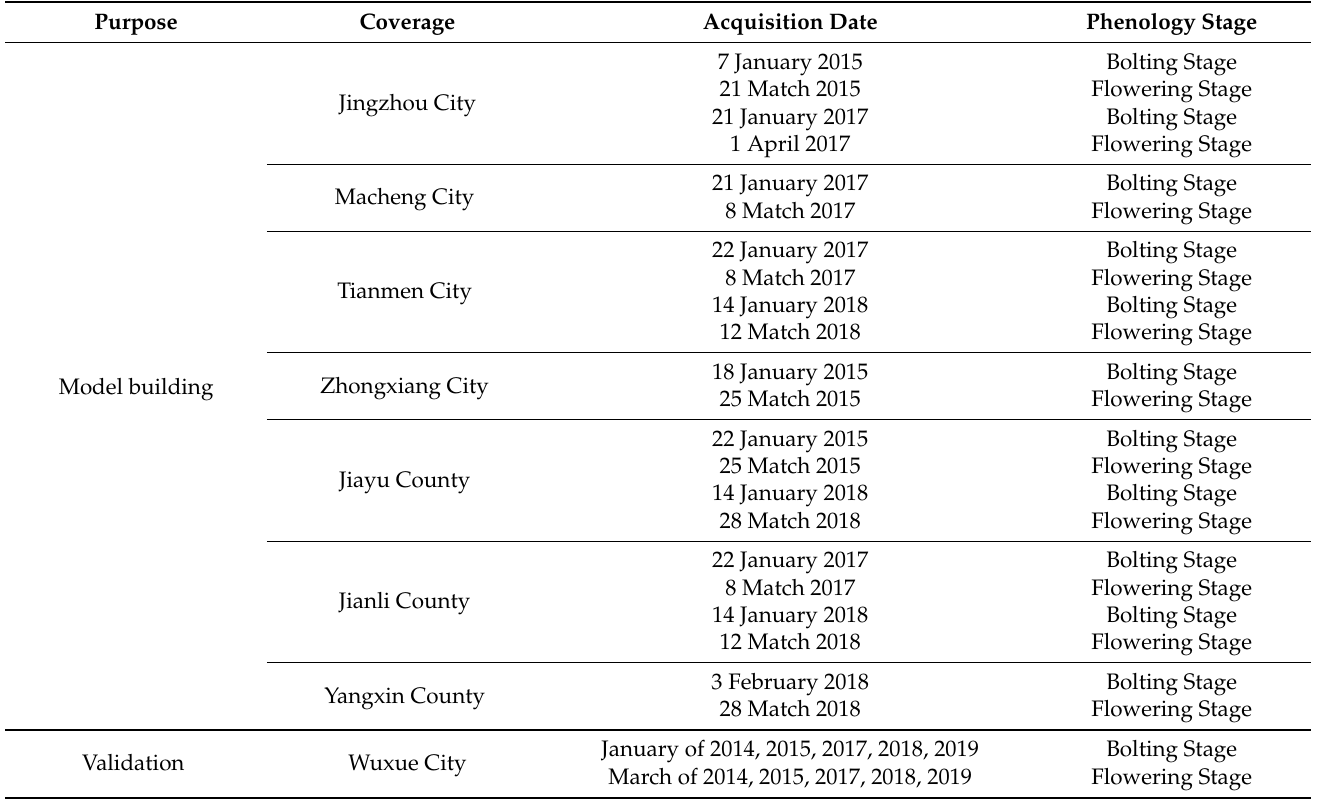
Table 1. The used Gaofen-1 WFV images to build and verify the